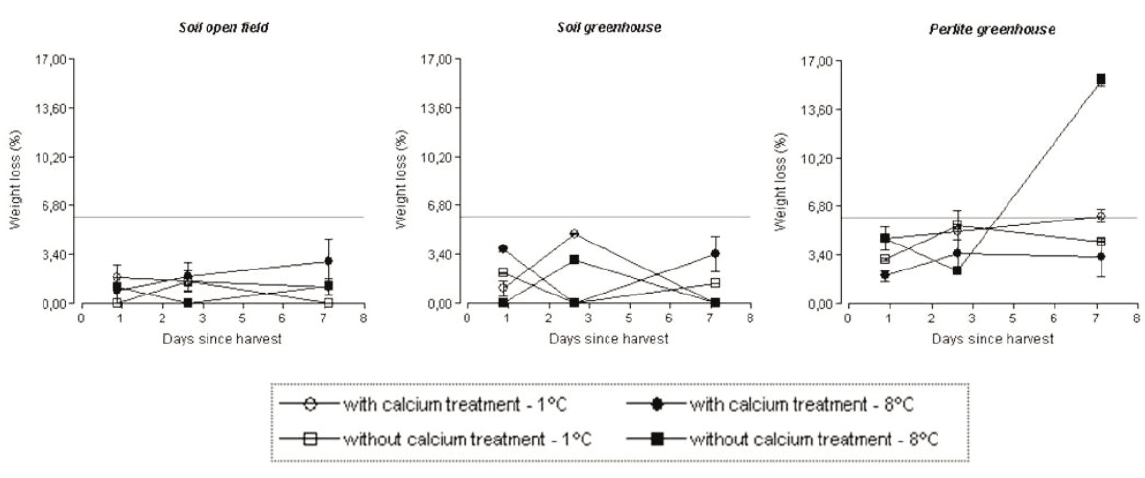
Fig. 2 - Fresh weight loss (%) at 1, 3 and 7 days of postharvest of strawberries grown in different growing systems, calcium lactate treat- ment and two storage temperatures. Maximum allowable weight loss (6%) is indicated.